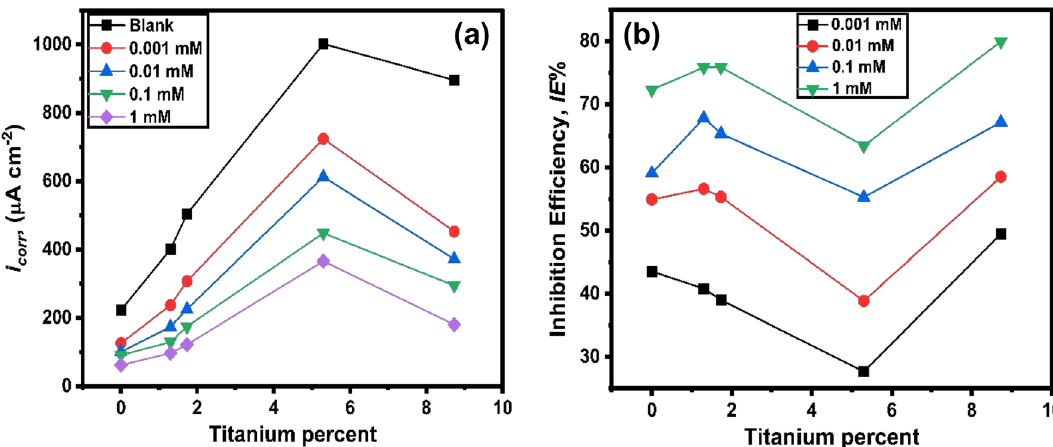
Figure 3. Comparison between both ( a ) i corr and ( b ) IE % with titanium percent in the alloy in 0.5 M solutions of HCl containing different concentrations of 2-MBT at 25